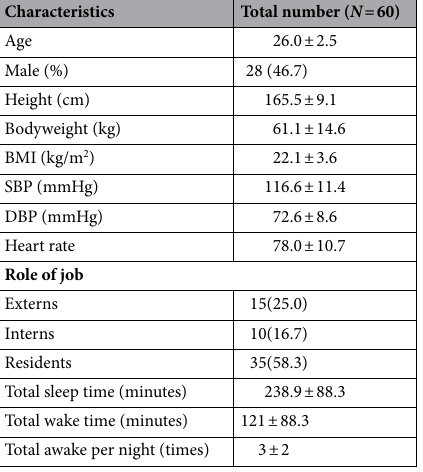
Table 1. Baseline characteristics. BMI body mass index, DBP diastolic blood pressure, SBP systolic blood pressure.